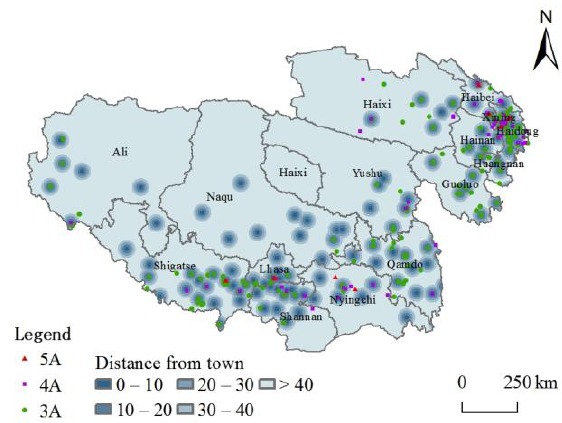
Figure 10. Spatial distribution of tourist attractions and towns.